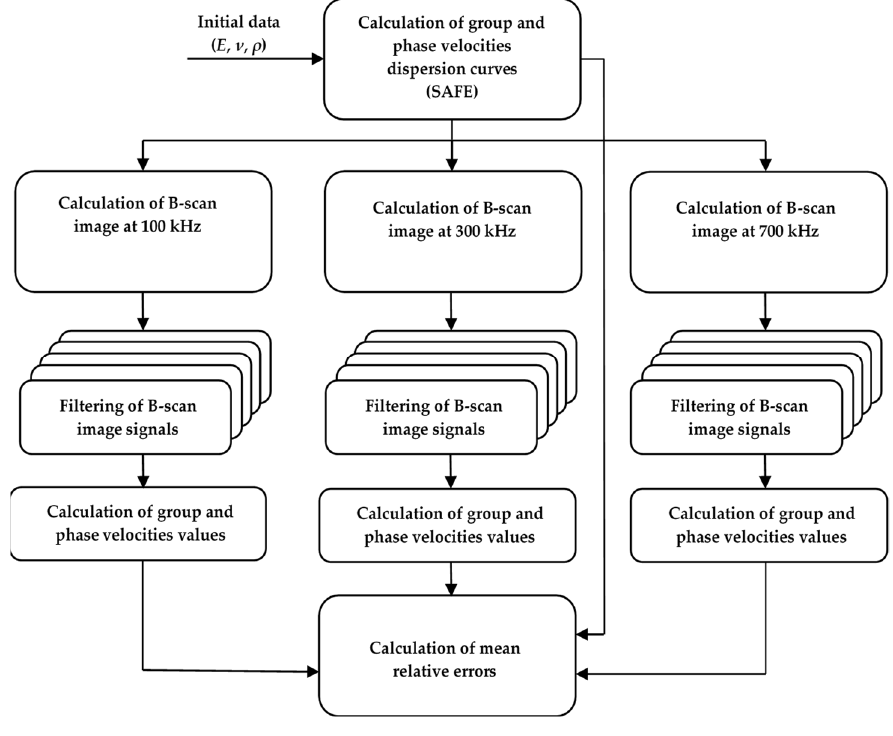
Figure 4. General verification algorithm of the Lamb wave A 0 mode group and phase velocity calculation method.